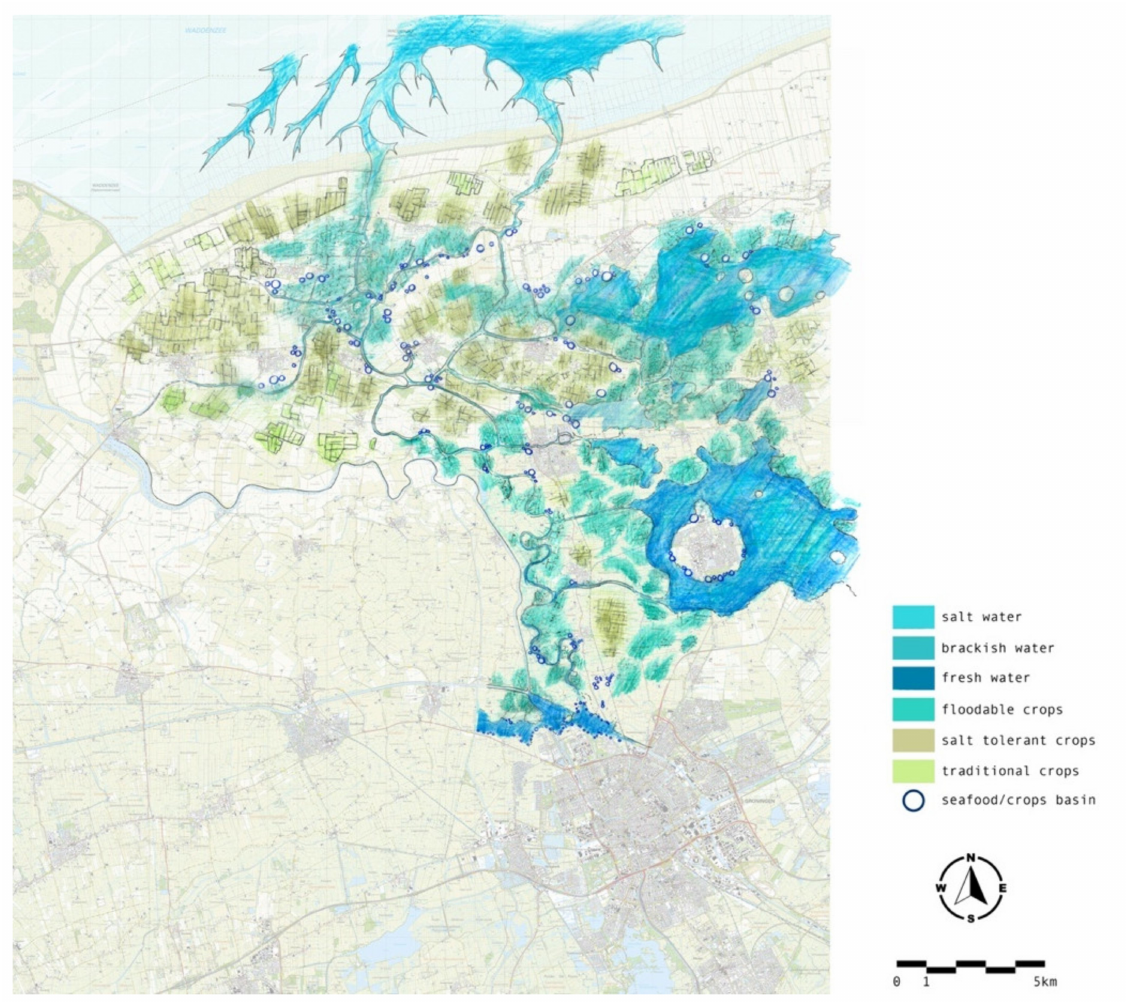
Figure 13. 2/3 of the area transformed into saline and brackish growing conditions bring a new agricultural